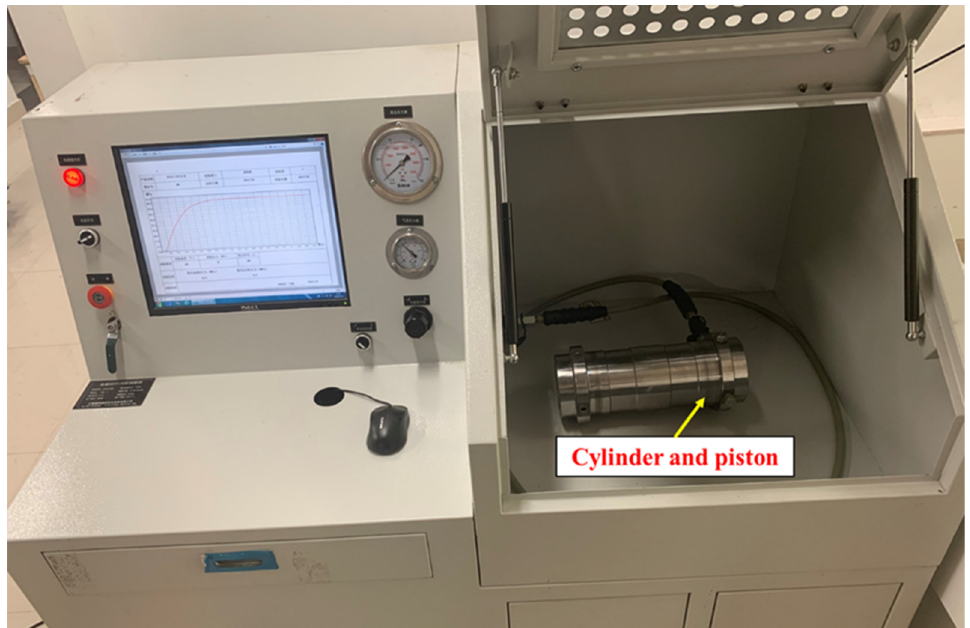
Figure 8. Pressure test of cylinder and piston. (In this test, we place the piston that has O-rings on both ends into the cylinder and fill the cylinder with water. This is then pressurized using a pneumatic booster. The maximum test pressure is 1.2 times the working pressure of the cylinder and piston, i.e., 120 MPa, and then, the pressure is held at 100 MPa for 12 h. No leaks or pressure drops were found in the device during the test. The test results show that the strength of the cylinder and piston meets the requirements.)